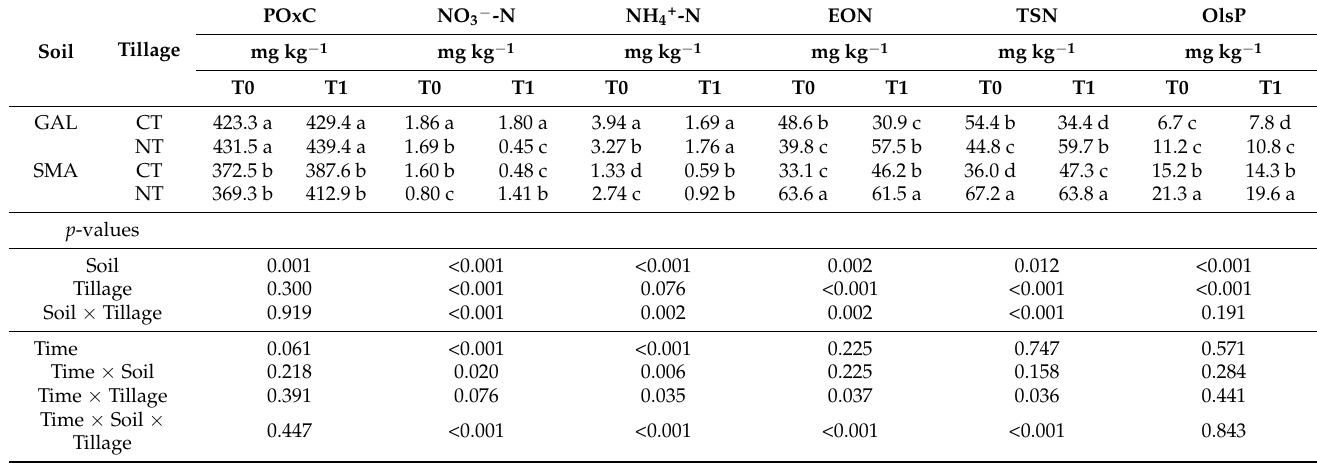
Table 3. Effect of soil (GAL and SMA), tillage system (CT and NT), sampling time (sowing—T0 and harvest—T1), and their interaction on soil permanganate oxidizable C (POxC), nitrate-N (NO 3 − -N), Reported values are means ( n = 4). Different letters indicate significant differences within